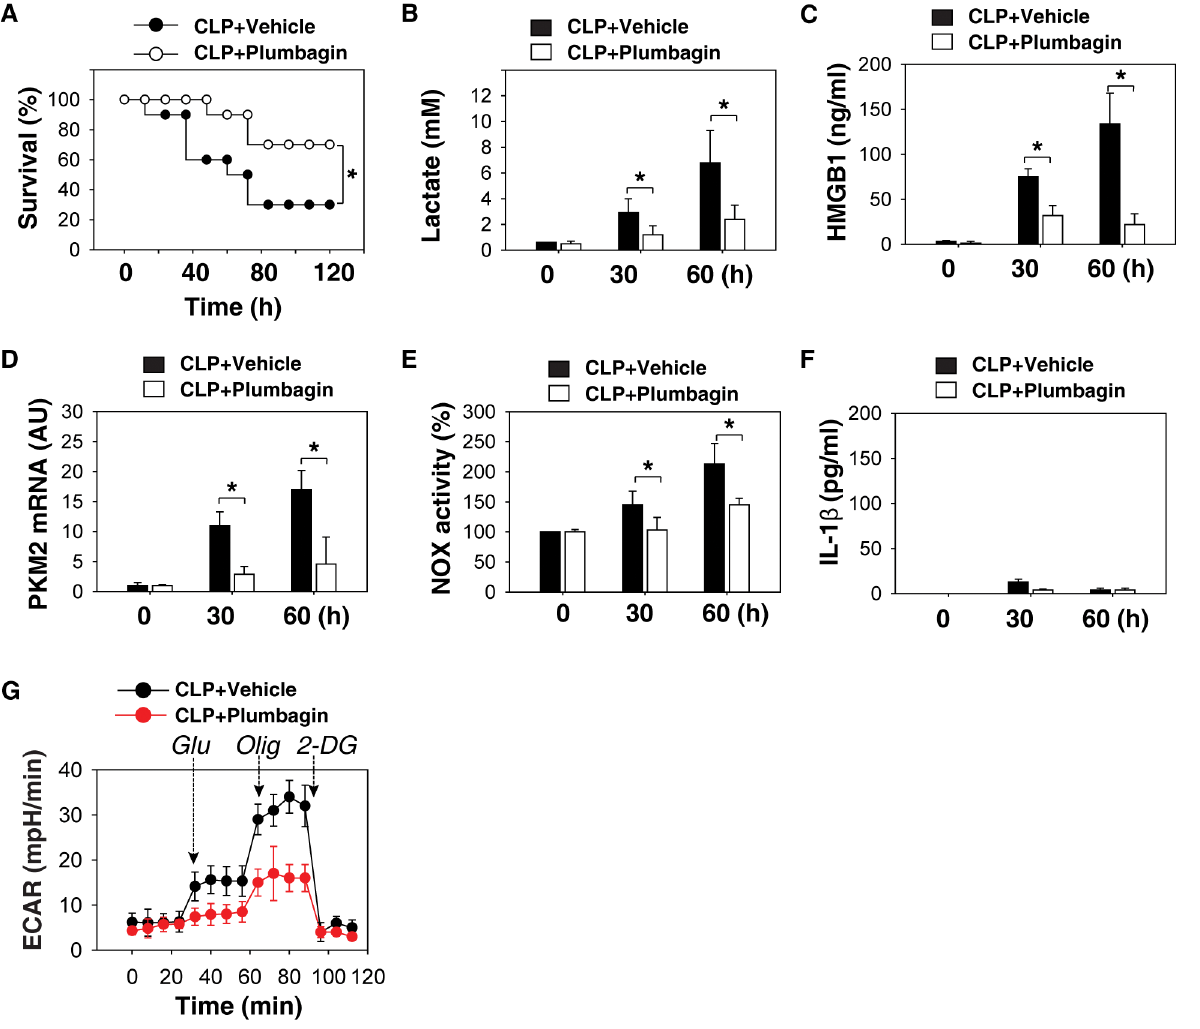
Figure 6. Delayed treatment with plumbagin protects mice from sepsis. (A) The cecal ligation and puncture (CLP) technique was used to induce intraabdominal sepsis in mice (n = 20/group). Repeated administration of plumbagin (4 mg/kg) at 24, 48, and 72 h after CLP significantly increased survival compared with vehicle grou p (*, p < 0.05), as measured by Kaplan-Meier test. (B-G) In parallel experiments, serum levels of lactate (B), IL-1 β (F), HMGB1 (C) and PKM2 mRNA (D), NOX activity (E) and ECAR (G) in isolated peritoneal macrophages at indicated time points were measured (n = 3–5 animals/group, values are mean ± SEM, *, p <